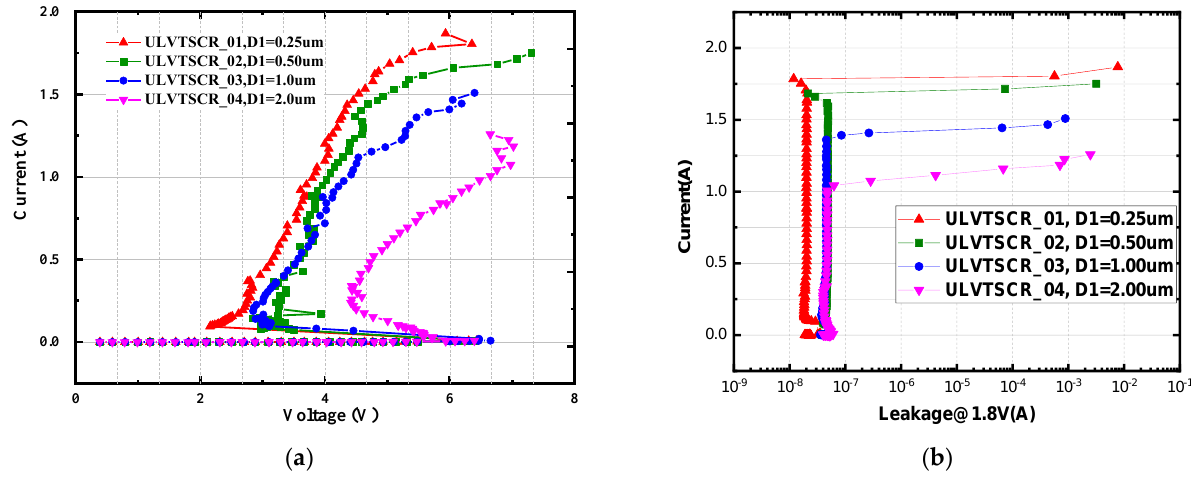
Figure 4. ( a )TLP I-V characteristics and ( b ) leakage of ULVTSCRs with different D1. Figure 4. ( a ) TLP I-V characteristics and ( b ) leakage of ULVTSCRs with different Table 2. Extracted Vh and It2 of ULVTSCR with D1 variation.